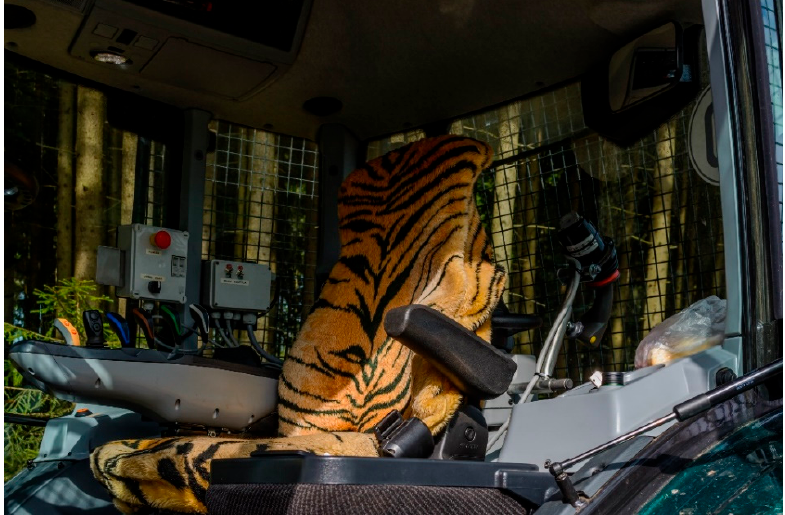
Figure 2. Operator’s workplace in a Valtra universal tractor.